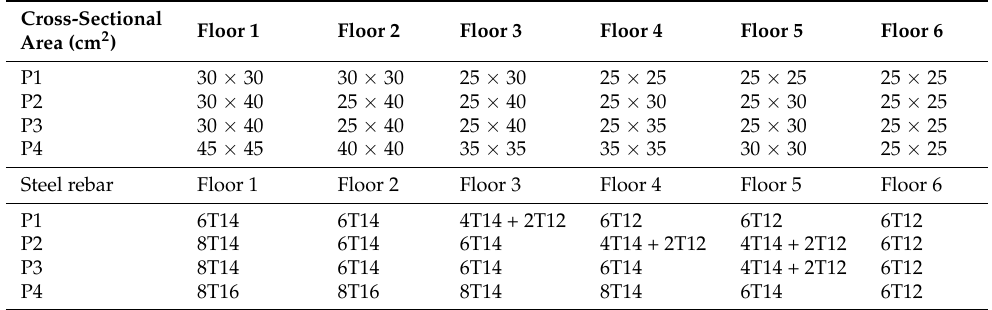
Figure 11. Distribution of column types for constructed models [39]. Table 5. Cross-sectional area of columns and adopted steel rebar for buildings with seismic code [39].